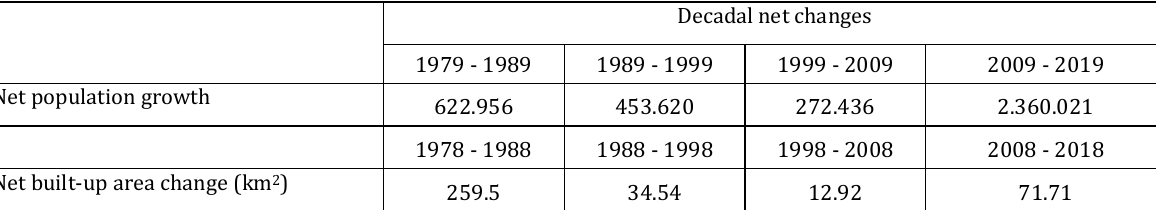
Table 3. Decadal net changes in population and built-up